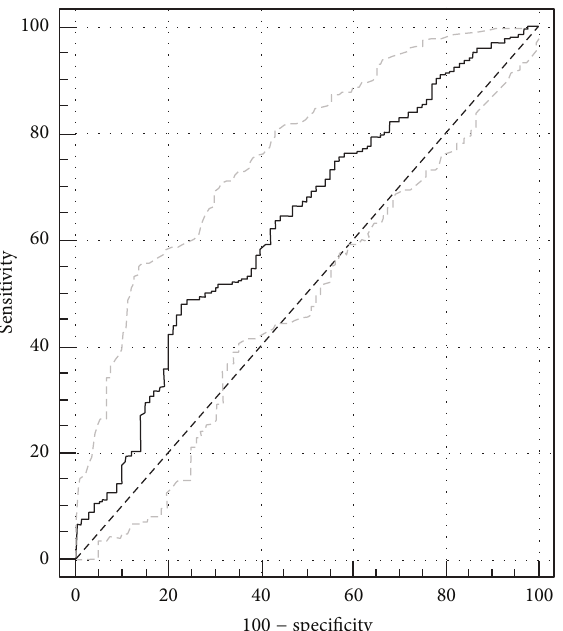
Figure 3: ROC curve of the true positive rate (sensitivity), false pos- itive rate (100-specificity) predictive values of the IL28B serum level concentration among patients infected with HCV and individual with liver cirrhosis+HCC